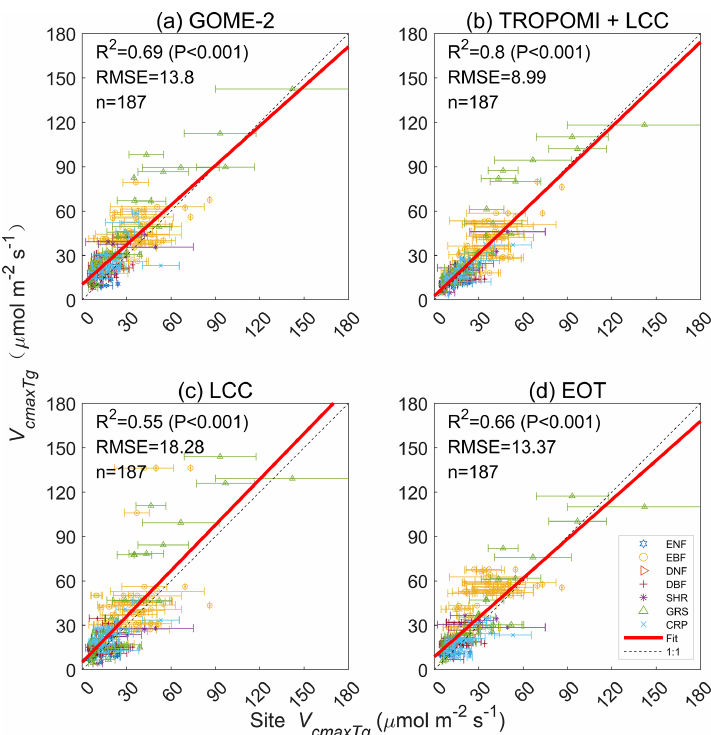
Figure 2. Comparisons of V cmax at growing season mean temperature ( T g ) derived from GOME-2 SIF, TROPOMI SIF + LCC, LCC, and optimality theory (EOT) against a ground database with 3672 individual data points aggregated to 180 grids of 0.5 ◦ resolution. The root mean square error (RMSE) is in unit of µmolm − 2 s − 1